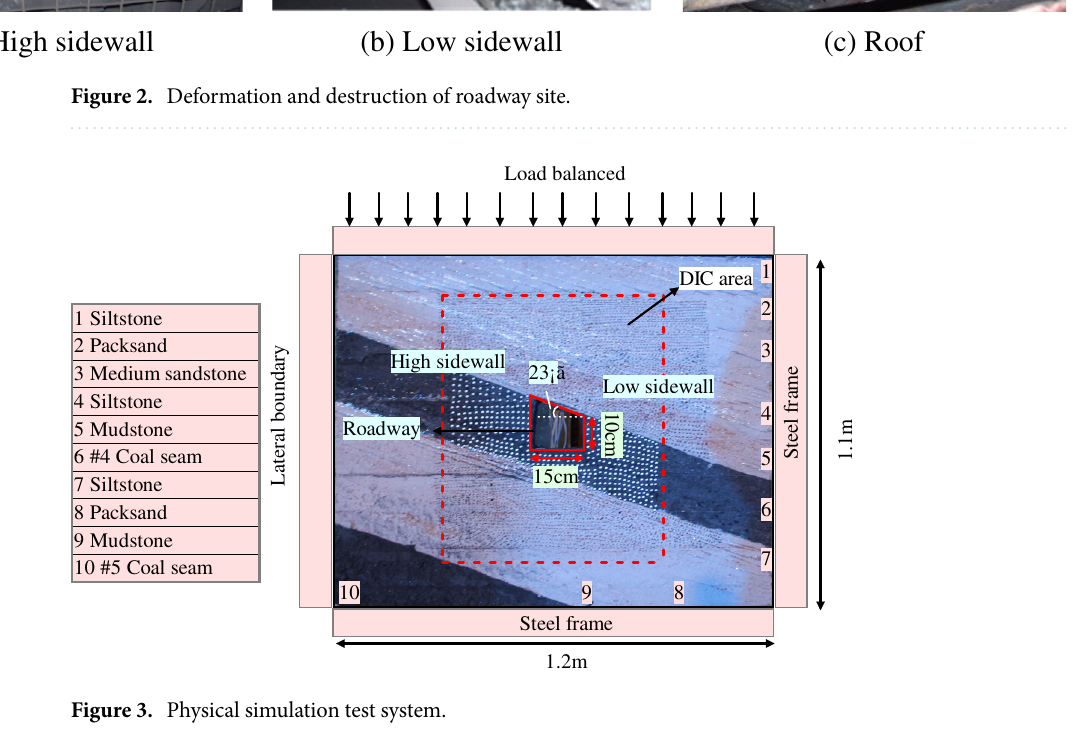
Figure 3. Physical simulation test